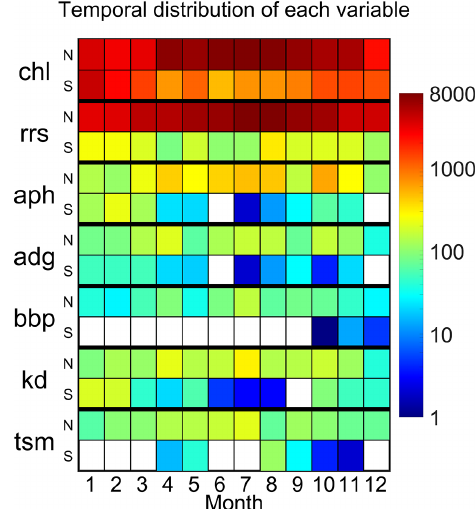
Figure 3. Temporal distribution of chlorophyll- a concentration (“chl”), remote-sensing reflectance (“rrs”), algal pigment absorp- tion coefficient (“aph”), detrital plus CDOM absorption coefficient (“adg”), particle backscattering coefficient (“bbp”), the diffuse at- tenuation coefficient for downward irradiance (“kd”), and total sus- pended matter (“tsm”) in the final table. All chlorophyll data were considered, but for a given station, HPLC data were selected if avail- able. Colours indicate the number of stations available for each vari- able as a function of month and hemisphere of data acquisition (“N” – Northern Hemisphere; “S” – Southern Hemisphere). The empty (white) squares indicate no data for that